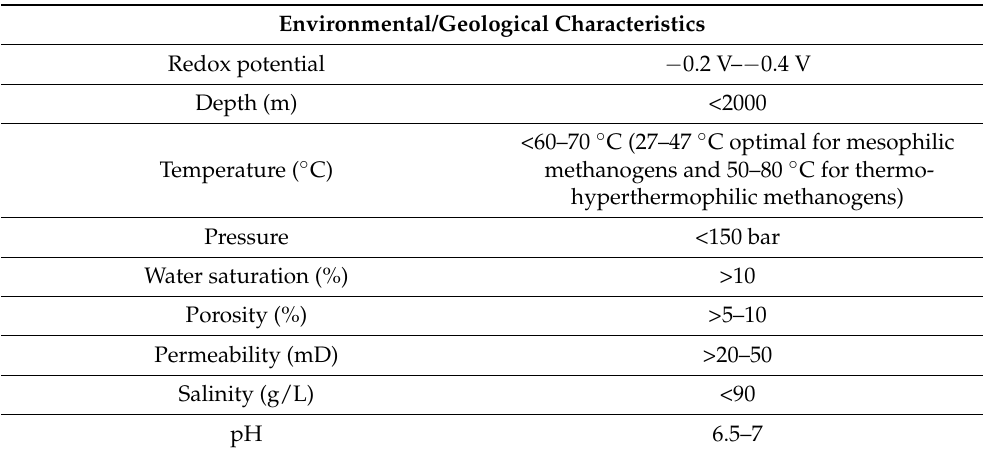
Table 2. Environmental factors and geological characteristics for a UMR site as reported by